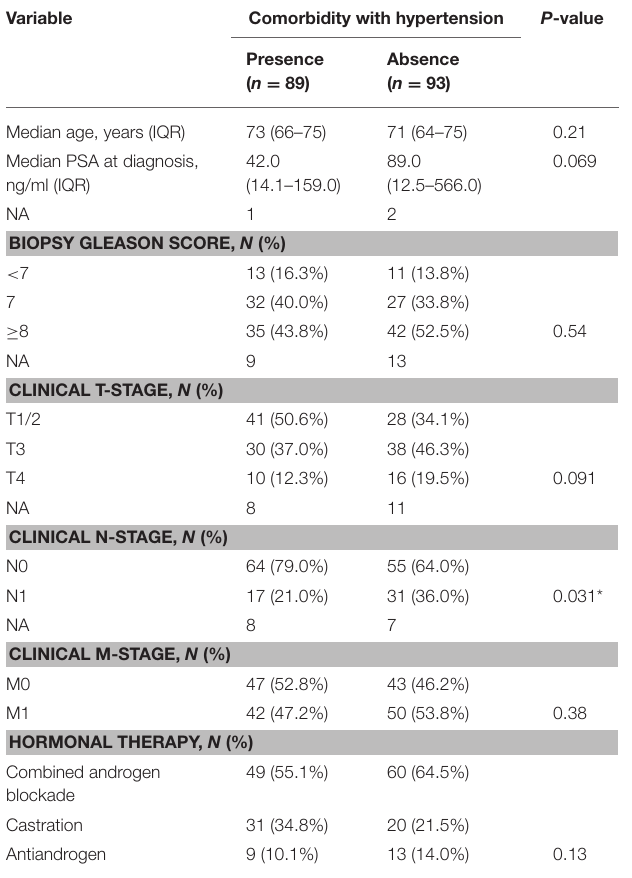
TABLE 3 | Patient characteristics among men undergone ADT stratified by comorbidity with hypertension. Variable